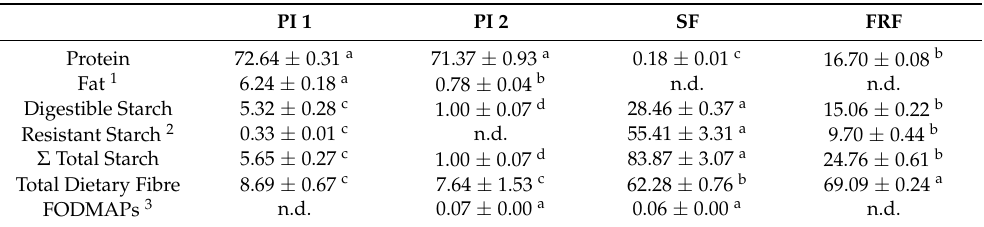
Table 1. Compositional analysis of faba bean fractions, average contents ± standard deviation (g/100 g